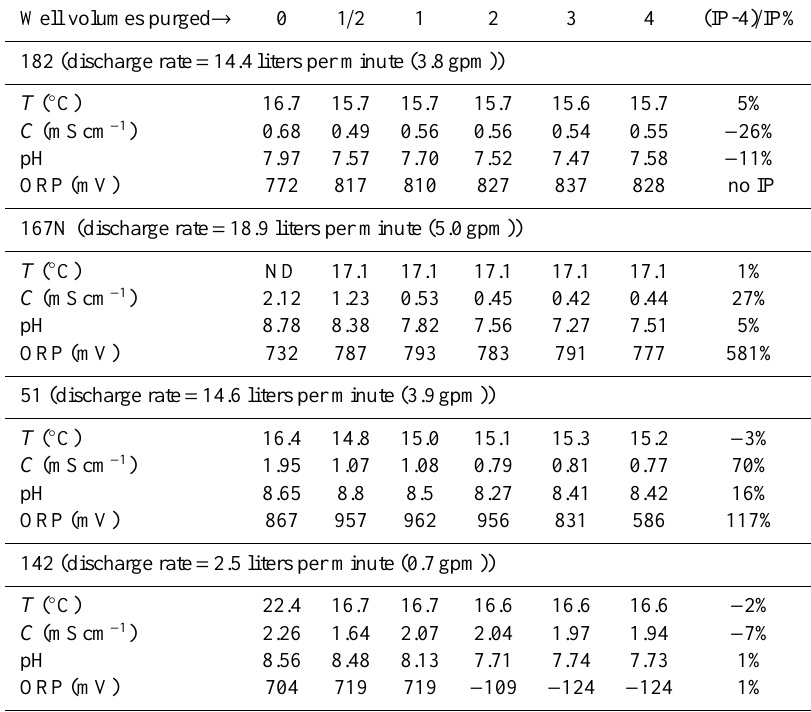
Table 4. Physical and chemical characteristics of water in test wells observed during post-chlorination purging ( T : temperature, C : conduc- tivity, ORP: oxidation-reduction potential, ND: not measured). Final column displays the percentage di ff erence between values at IP (prior to chlorination) and post-chlorination, with 4 well volumes